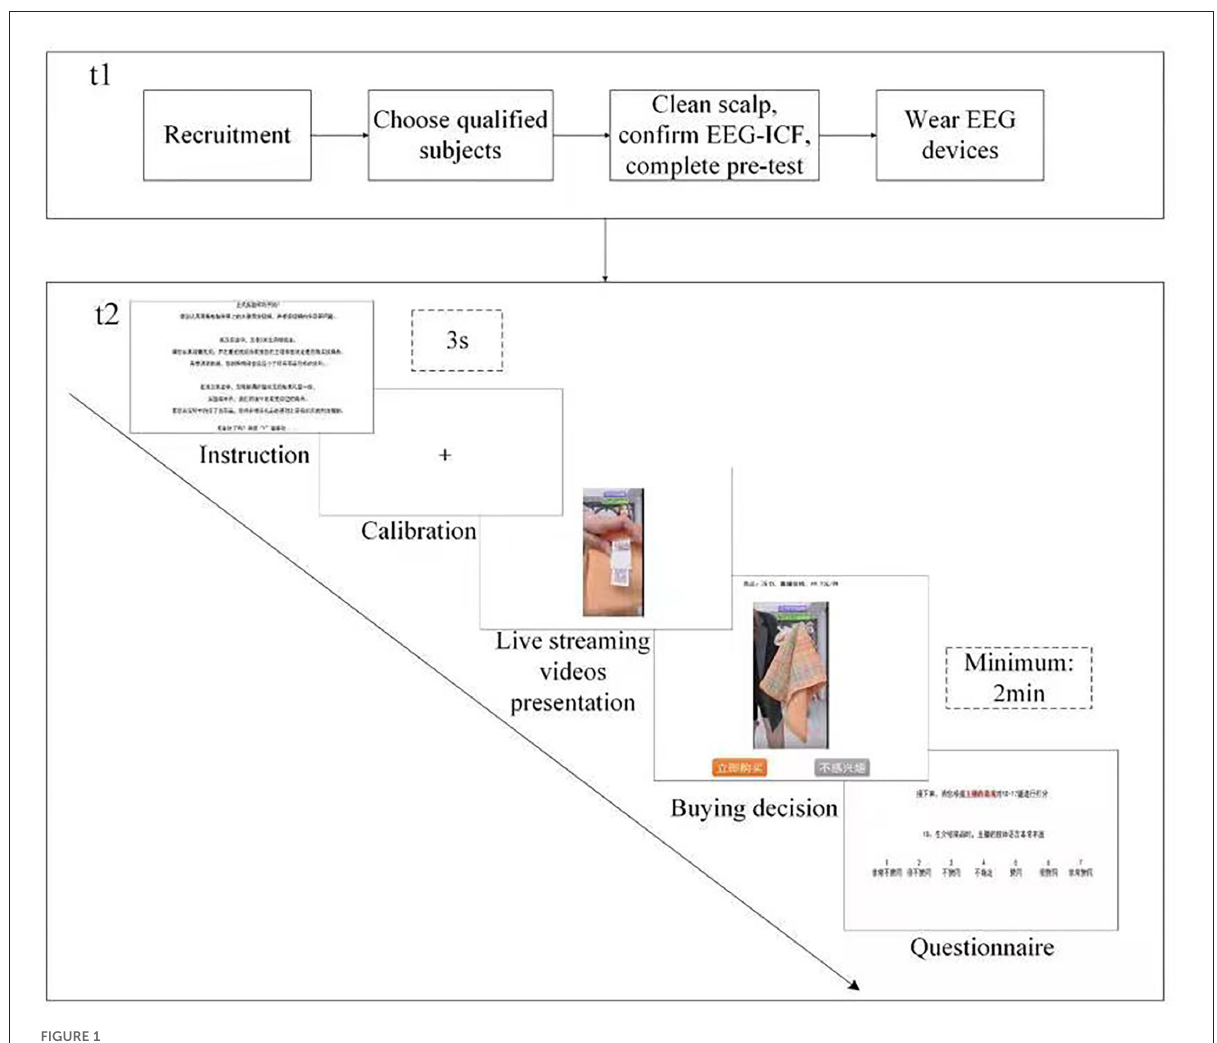
FIGURE1 Experimental